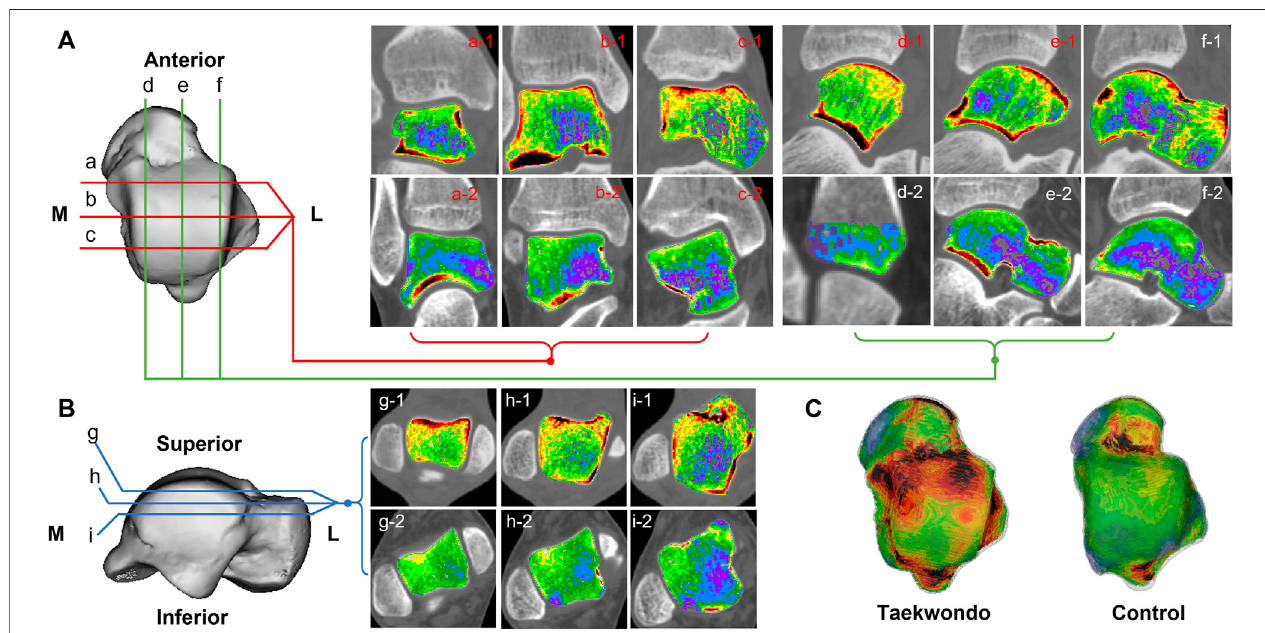
FIGURE3| Computedtomographicimagesofthedistributionofbonetissueofdifferentbonedensitiesinthetalusoftwogroups. (A) isaschematicdiagramofthe coronal and sagittal tomographic images of the talus; (B) is a schematic diagram of the axial tomographic images of the talus; (C) is a schematic diagram of the superimposed bone tissue of each bone density in the talus. a1 – c1 are the coronal images of Taekwondo; d1 – f1 are the sagittal images of Taekwondo; g1 – i1 are the axial images of Taekwondo; a2 – c2 control group coronal images; d2 – f2 control group sagittal images; g2 – i2 control group axial images.